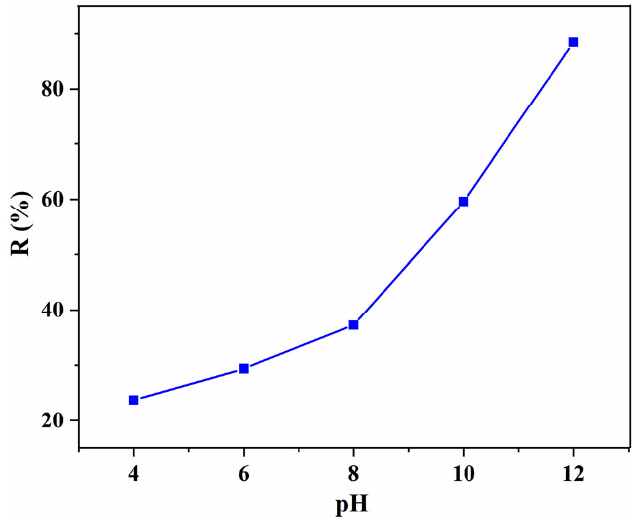
Figure 6. Effect of the initial pH on the removal efficiency with 40% Tan/SA beads ( C 0 = 80 mg/L, T = 25 °C, t = 4 h).